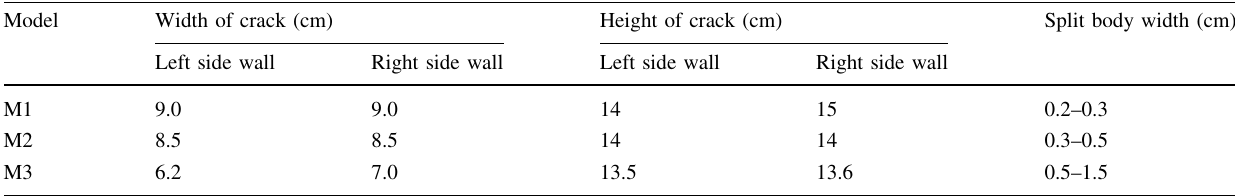
Table 3 Width data of the cracks in the three arch models